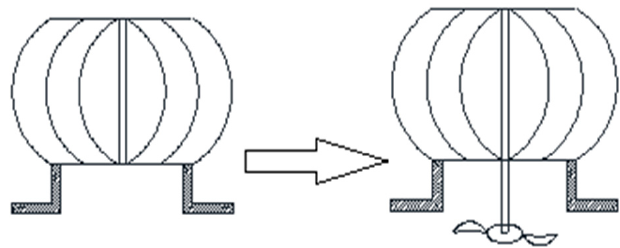
Figure 1. Natural ventilator before and after optimization.